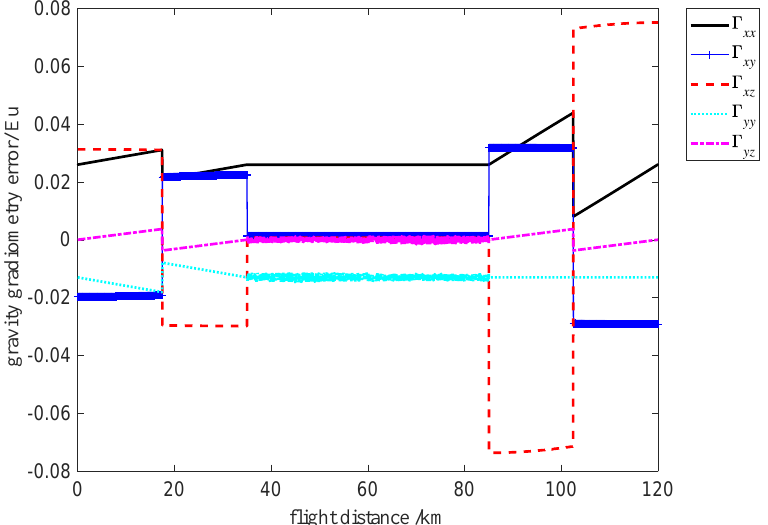
Figure 11. Self-gradient compensation